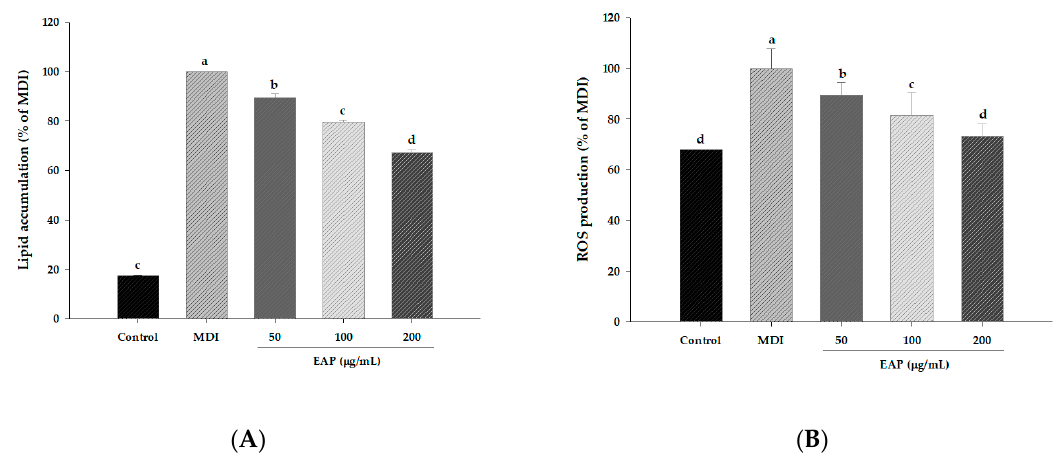
Figure 3. Effects of EAP water extract on lipid accumulation ( A ) and ROS production ( B ) in 3T3-L1 adipocytes. EAP: Erigeron annuus (L.) Pers. water extract, 3T3-L1 preadipocytes were induced to differentiate in the presence of EAP (added on D0 of differentiation) for seven days. ( A ) Lipid accumulation was determined by measuring absorbance at 490 nm. ( B ) ROS production was determined by using nitro tetrazolium blue chloride and absorbance at 570 nm. Values are presented as mean ± standard deviation. Differences between means were considered statistically significant at P < 0.05.